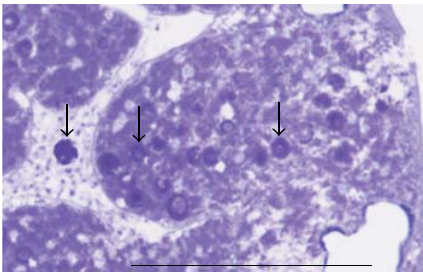
Figure 23: Further detail of granules (arrows) that originate from the gland cell shown in Figure 22. Scale bar = 30 μ m.